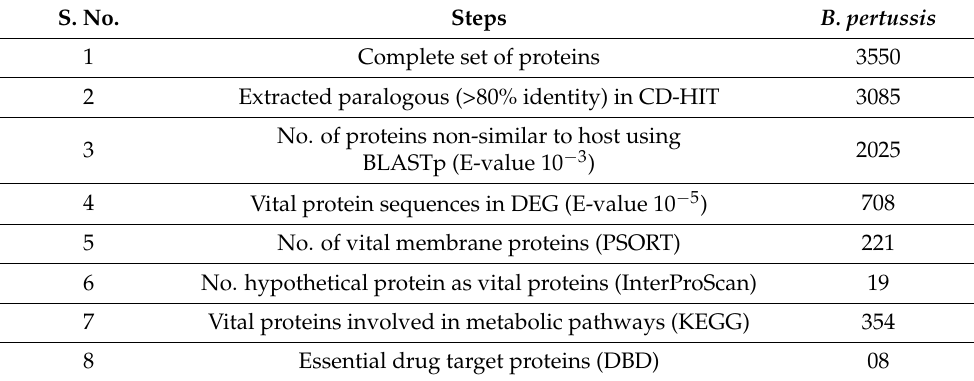
Table 1. The various steps of subtractive genomics and their results. S. No.